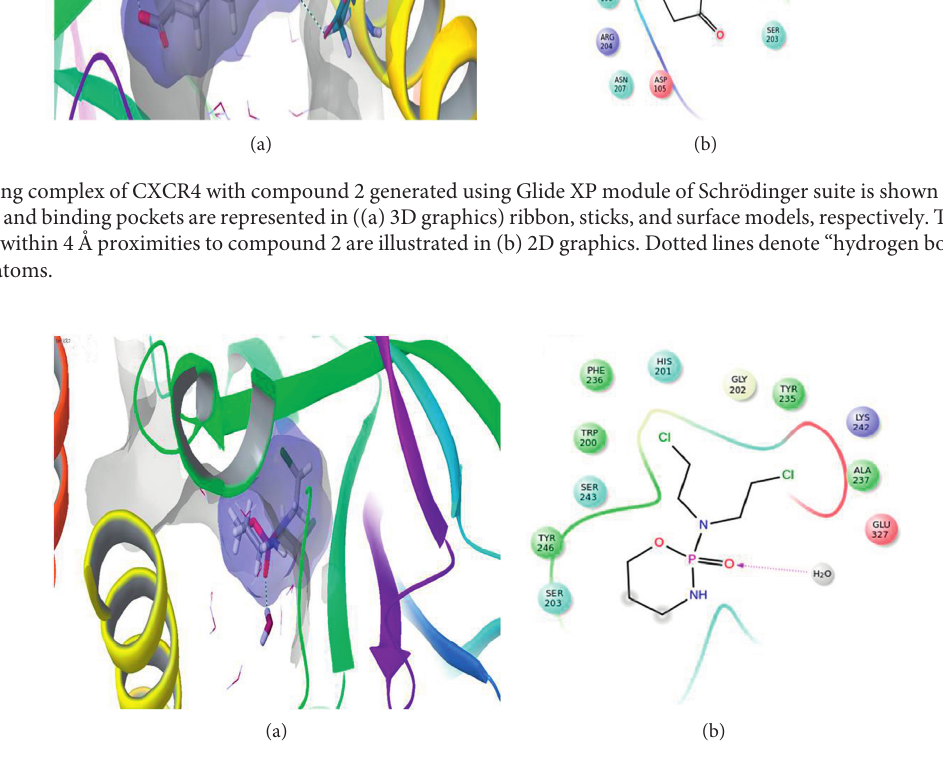
Figure 7: Docking complex of CXCR4 with cyclophosphamide generated using Glide XP module of Schr¨odinger suite is shown in this figure. The proteins, ligand, and binding pockets are represented in ((a) 3D graphics) ribbon, sticks, and surface models, respectively. The residues of the CXCR4 that are within 4 ˚A proximities to the cyclophosphamide are illustrated with (b) 2D graphics. Dotted lines denote “hydrogen bonds” between the corresponding atoms. Table 3: ADME property prediction of screened